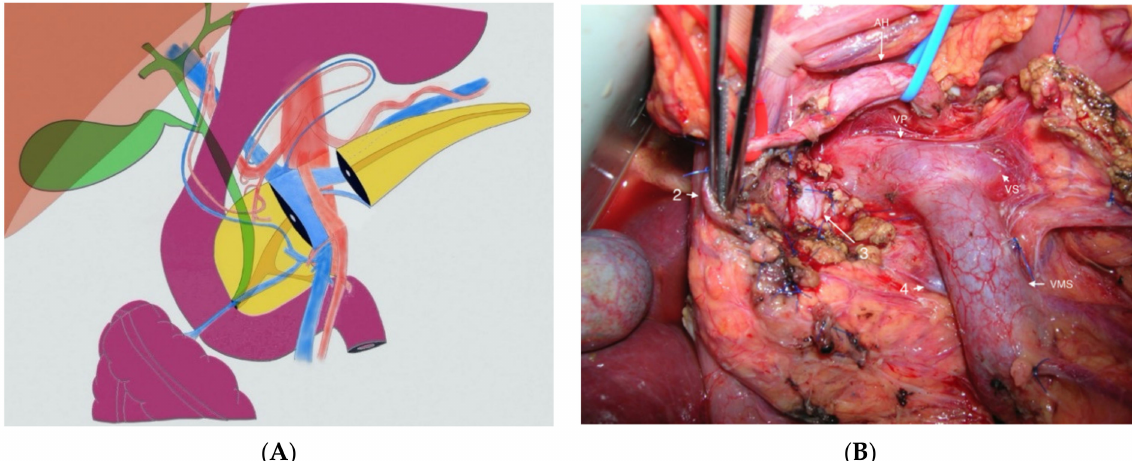
Figure 4. Central pancreatectomy: ( A ) Schema; ( B ) Central pancreatectomy extended to the right for isthmic pancreatic tumor. AH: hepatic artery; VP: portal vein; VS: splenic vein; VMS: superior mesenteric vein; 1: Gastroduodenal artery; 2: Superior pancreaticoduodenal artery; 3: common bile duct; 4: Inferior pancreaticoduodenal